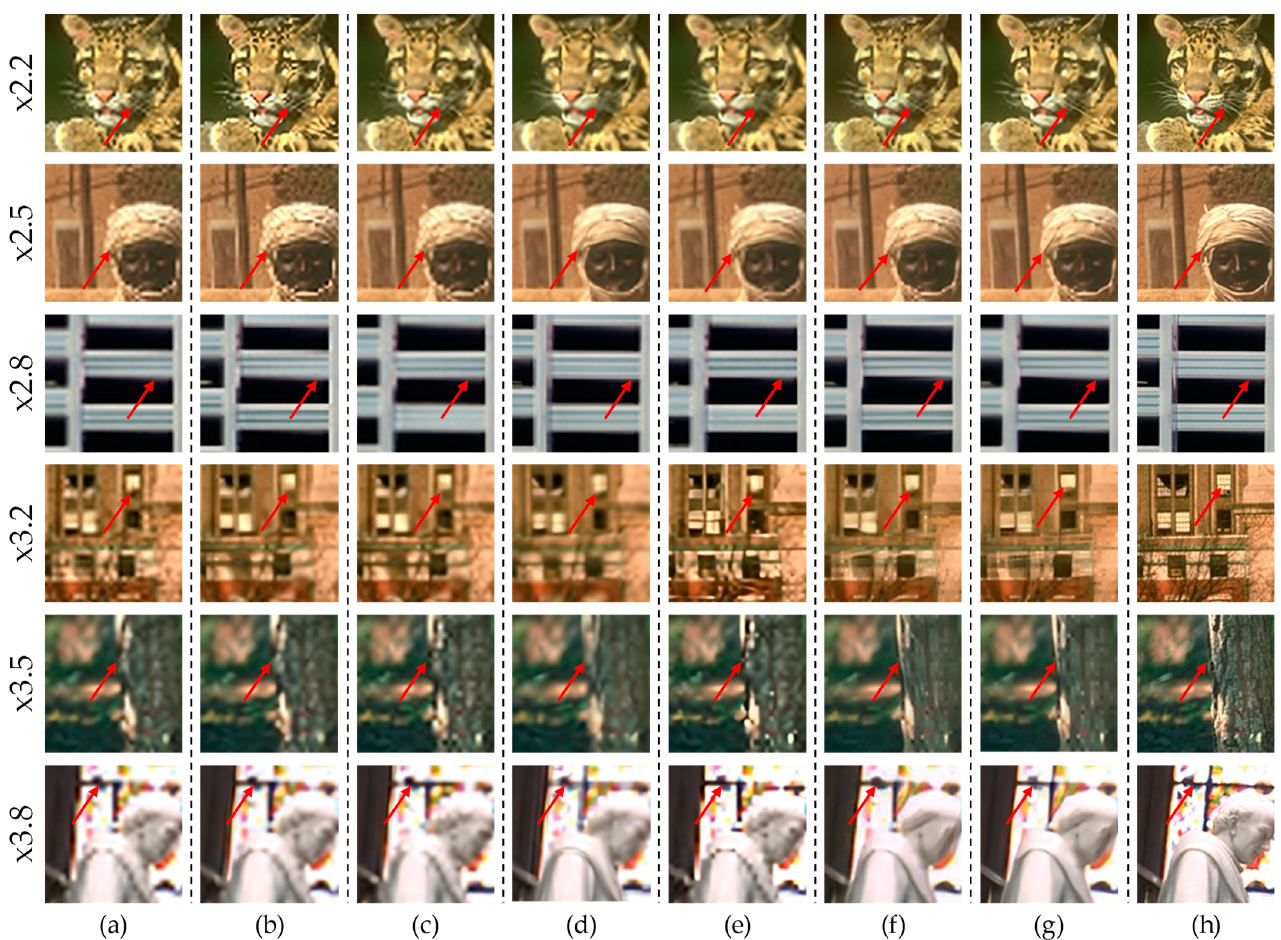
Figure 11. Super-resolution reconstruction results: ( a ) bicubic results; ( b ) RDN results; ( c ) HAN results; ( d ) SwinIR results; ( e ) CSNLN results; ( f ) RDN + META-SR results; ( g ) RDN + H 2 A 2 -SR results; ( h ) high-resolution images.